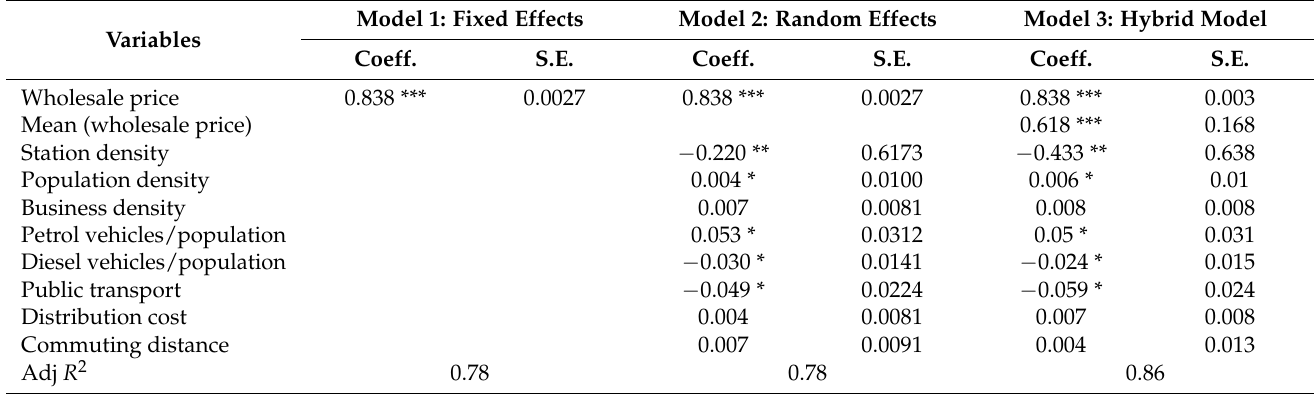
Table 8. Determinants that influenced the retail petrol price at a city level when considering the wholesale petrol price as a proxy for the upstream cost.